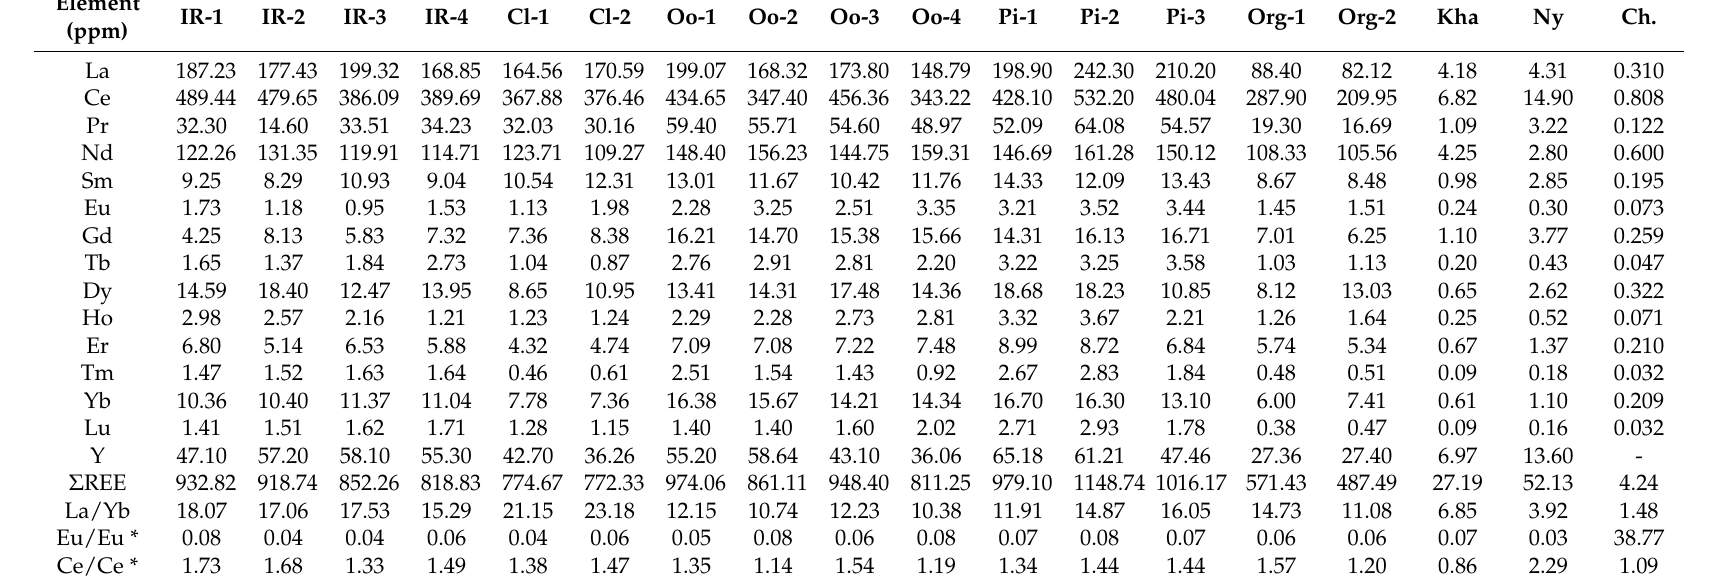
Table 3. Rare earth element composition of samples from the Dopolan bauxite